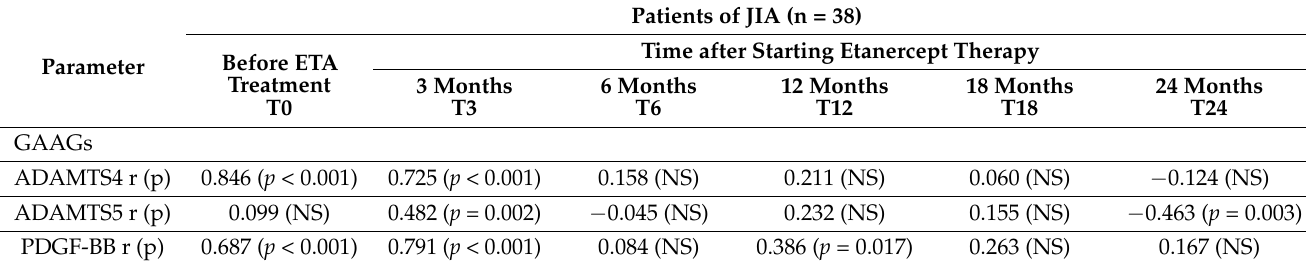
Table 3. Correlation analysis between plasma GAAGs, COMP, and YKL-40, and ADAMTS4, ADAMTS5, and PDGF-BB levels in JIA